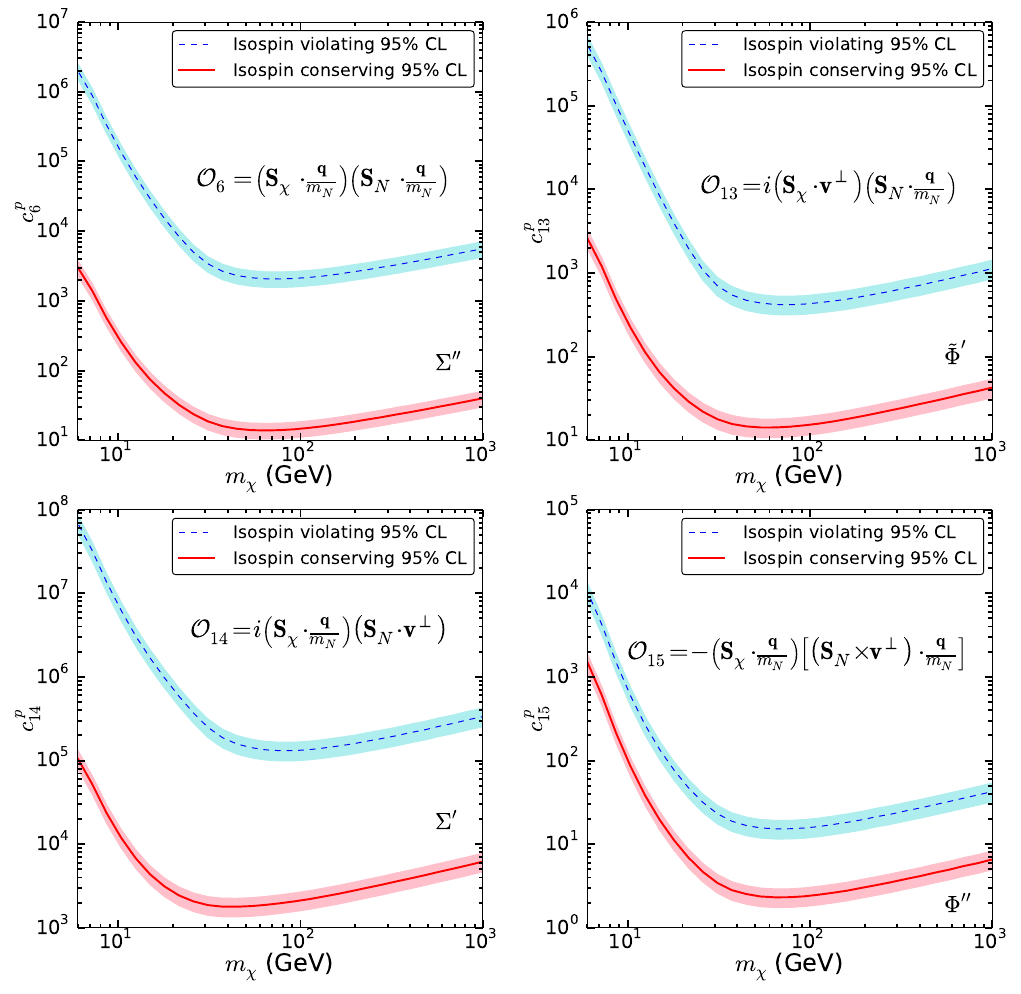
Figure 4 . Same as (cid:12)gure 2 but for operators O 6 , O 13 , O 14 and O 15